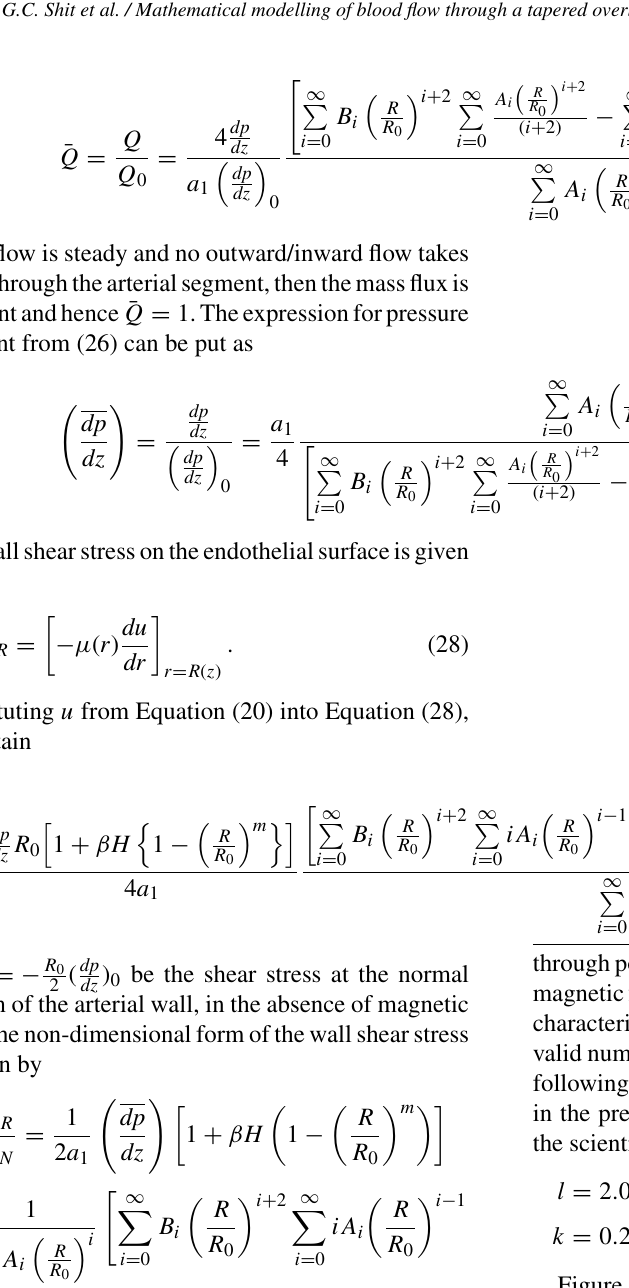
Figure 2 indicates the different locations of the stenosis in the axial direction. In Fig. 2, z = 0 . 5 and z = 3 . 5 correspond to the onset and outset of the steno- sis and z = 1 and z = 3 represent the throat of the primary stenosis and secondary stenosis